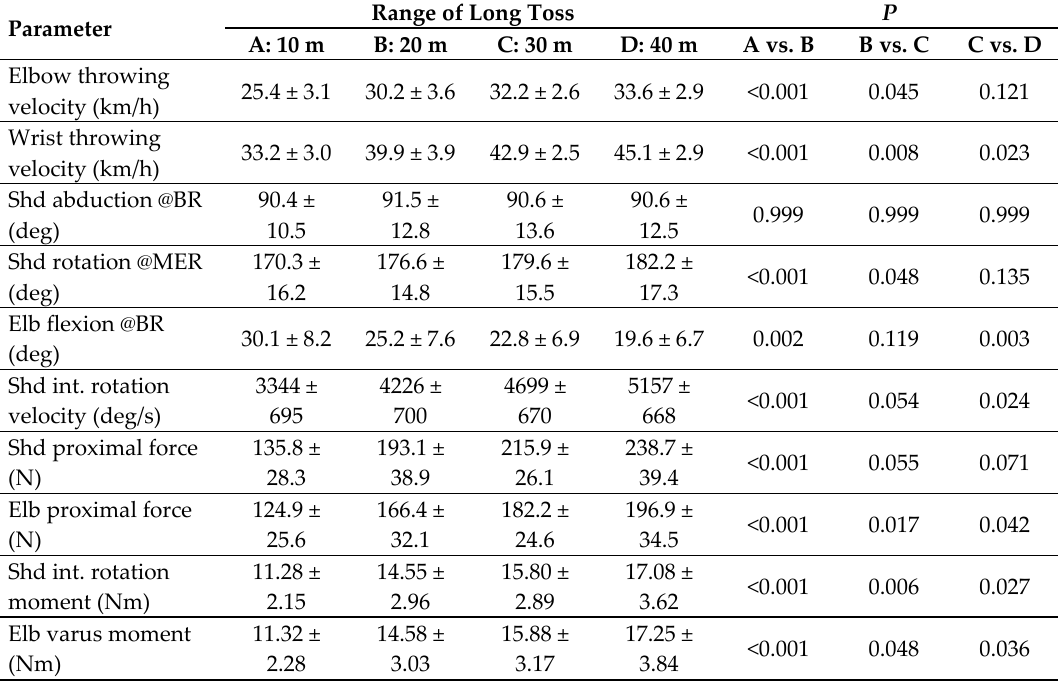
Table 2. Throwing kinematics and kinetics of subjects who could throw long-range: n = 12.